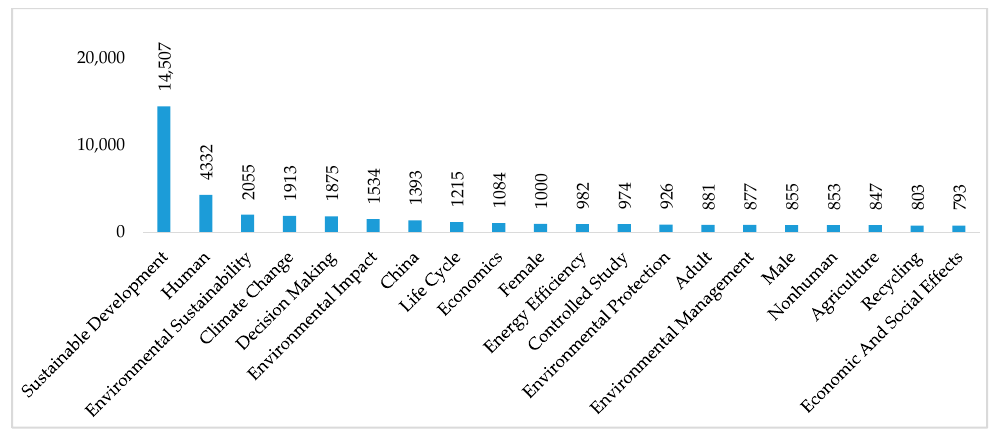
Figure 7. Research topics on sustainability between 2019 and 2020.